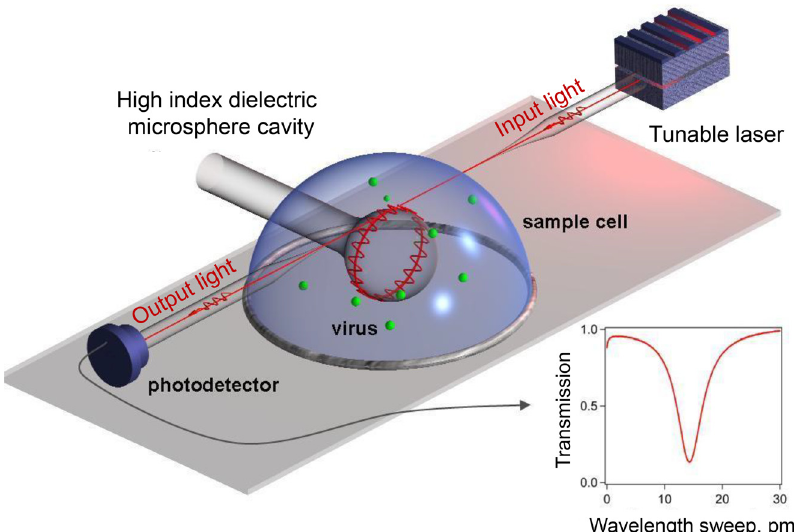
Figure 5: Measuring the presence of a virus using a whispering gallery resonator. As virus molecules bind to the surface, the resonant wavelength position shifts, which is measured by the